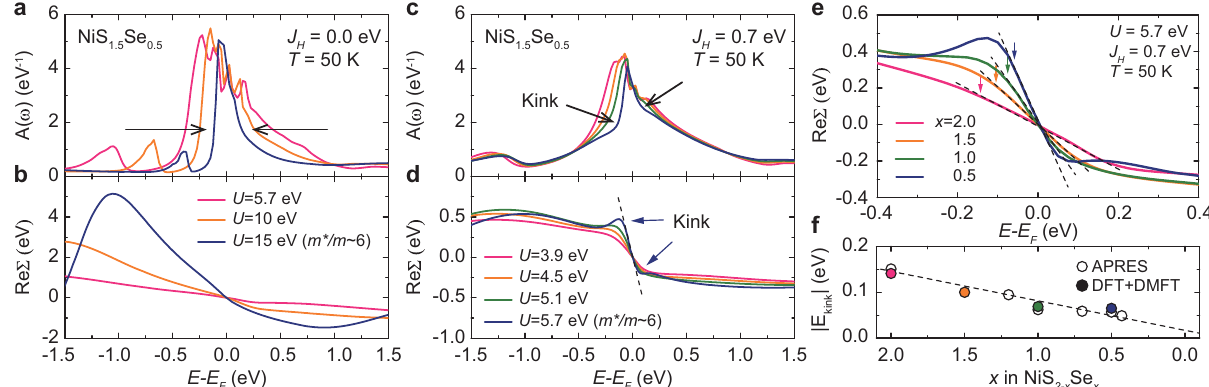
Fig. 3 Self-energy and spectral function evolution with and without Hund ’ s coupling. a – d Calculated partial density of states for Ni e g orbitals and corresponding real part of the self-energy Re Σ ( ω ) for various U values without and with J H , respectively. e Calculated Re Σ ( ω ) for various Se contents. Re Σ ( ω ) results are vertically shifted for easier comparison. f Kink energy scale obtained from APRES and DMFT